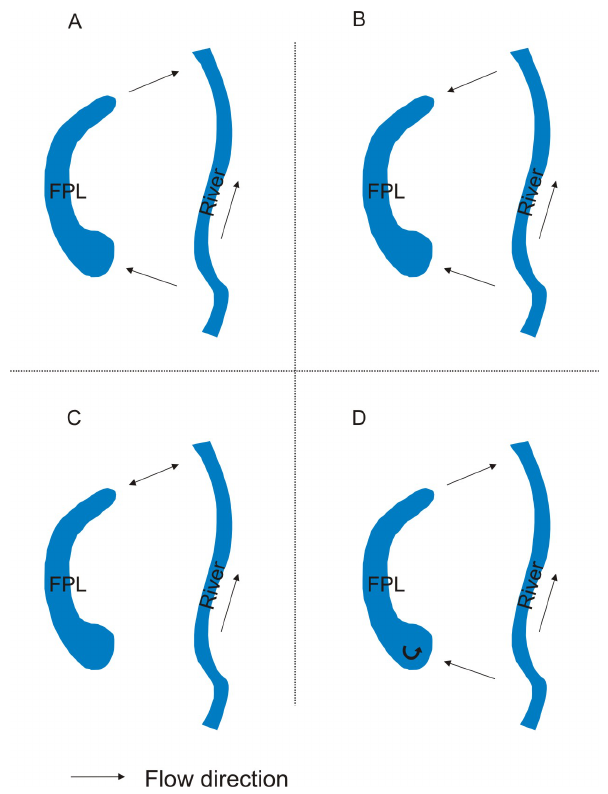
Fig. 1. Types of possible connections of the floodplain lakes to the Bug River in the present study: (A) confluent inflow, (B) contraflu- ent inflow, (C) contrafluent–confluent inflow, and (D) confluent– profundal